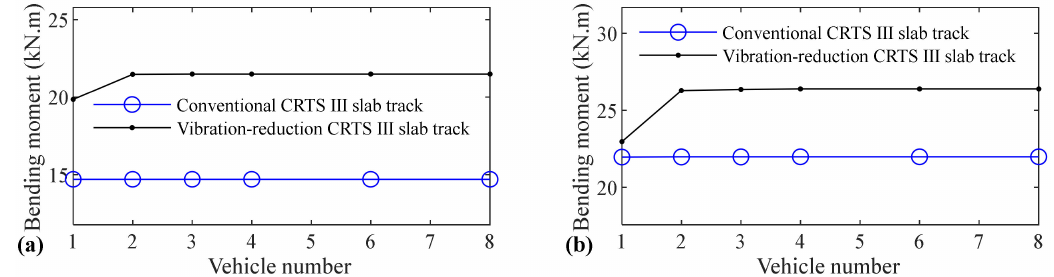
Figure 9. Relation between vehicle number and positive bending moment of rail: ( a ) without and ( b ) with random track irregularity.